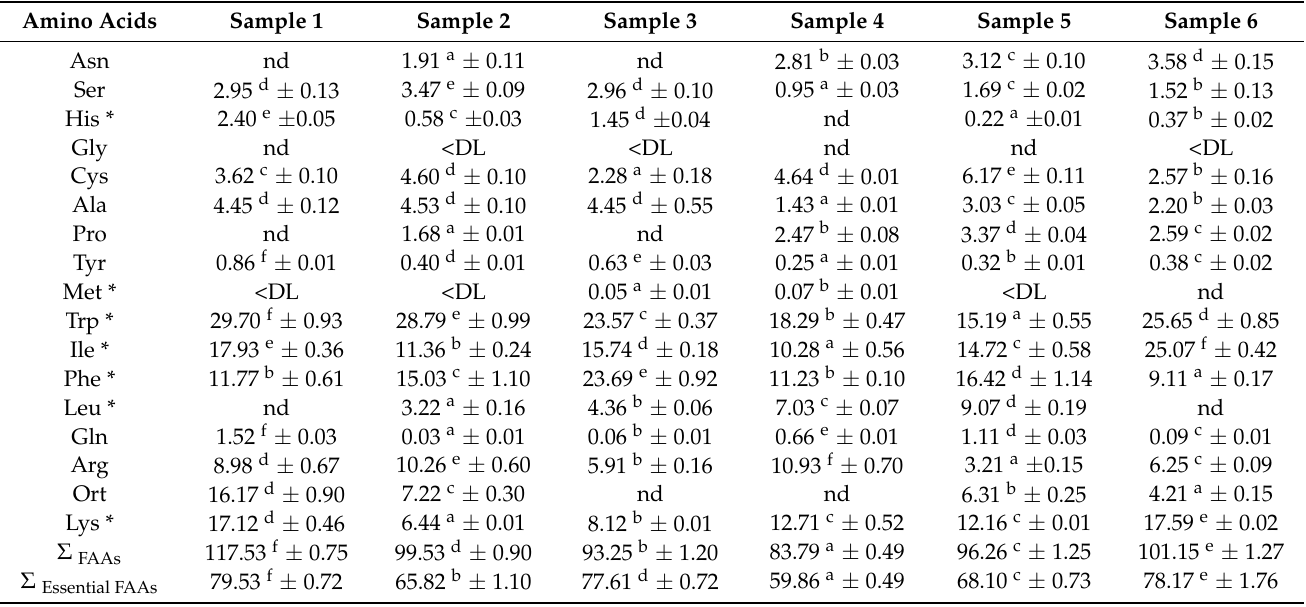
Table 3. The level of free amino acids in tested beverages (X ± SD; mg · 100 mL − 1